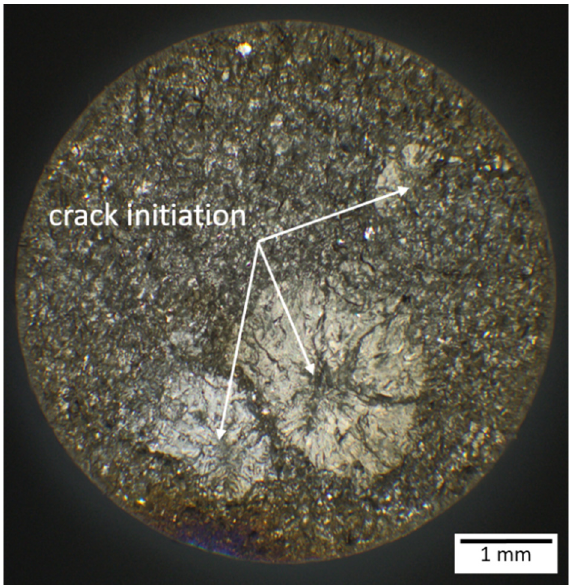
Figure 8. Fracture surface showing multi crack initiation in the volume of an SP sample fatigued at 230 MPa.